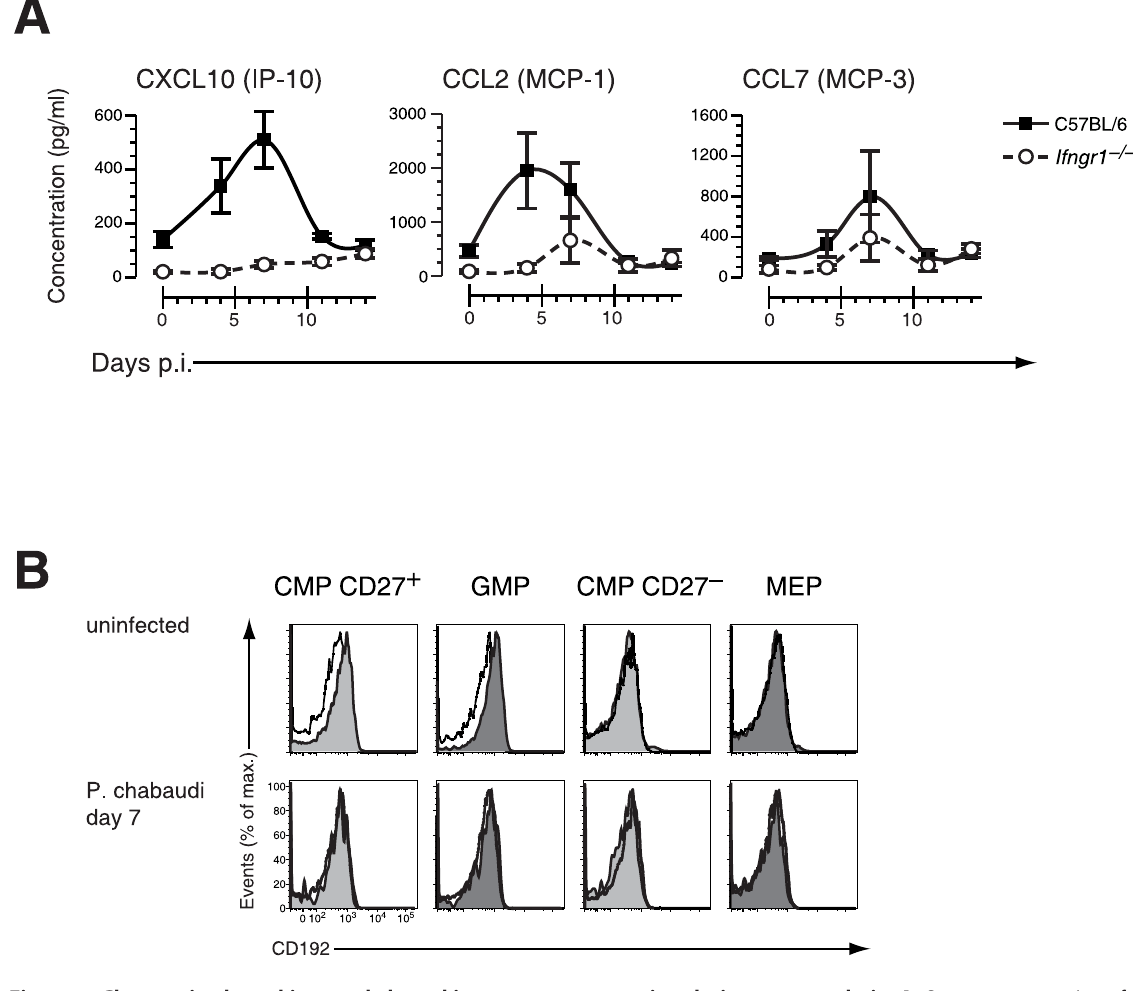
Figure 5. Changes in chemokines and chemokine receptor expression during acute malaria. A. Serum concentration of IFN- c induced chemokines in C57BL/6 and Ifngr1 -deficient mice infected with P. chabaudi . Data are shown as mean 6 SEM of serum concentration of respective chemokine in three infection experiments with 5–6 mice per each experimental group. B. Cell surface expression of CD192 (CCR2) on myelo-erythroid progenitors in the BM of mice infected with P. chabaudi day 7 (lower part) or before infection. All data are representative of two independent experiments with 4–5 mice per group each. Black line represents signals in Ccr2 2 / 2 animals for comparison.